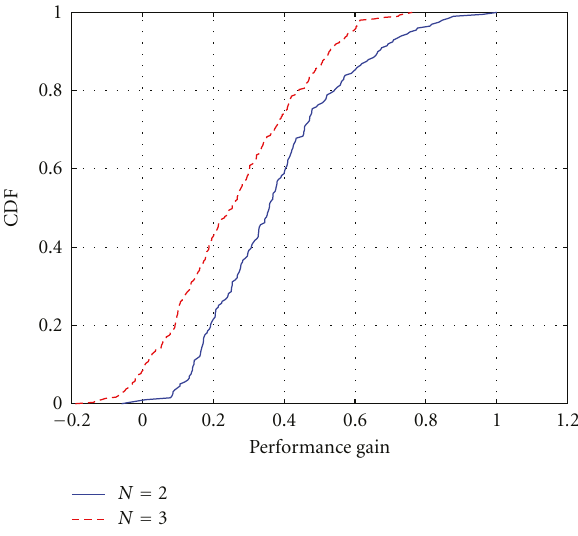
Figure 6: An example of dynamics of the Q -learning when N = 2, γ = 0 . 01, and system state is fully observable.